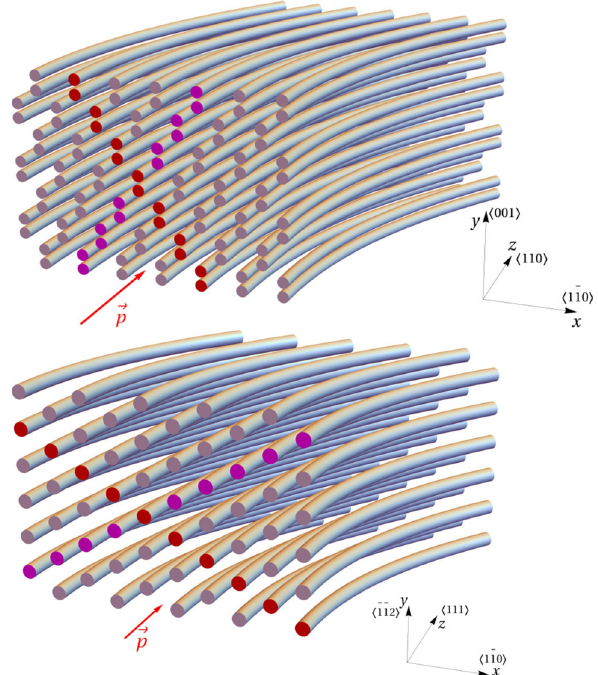
Fig. 1 IllustrationofatomicstringslocationinSicrystalorientedalong the (cid:2) 110 (cid:3) axis (top figure) and along the (cid:2) 111 (cid:3) axis (bottom figure). For the (cid:2) 110 (cid:3) orientation red color shows ( 1 ¯ 11 ) plane, magenta color shows ( ¯ 111 ) plane and for the (cid:2) 111 (cid:3) orientation red color shows ( 0 ¯ 11 ) plane, magenta color shows ( ¯ 101 ) plane